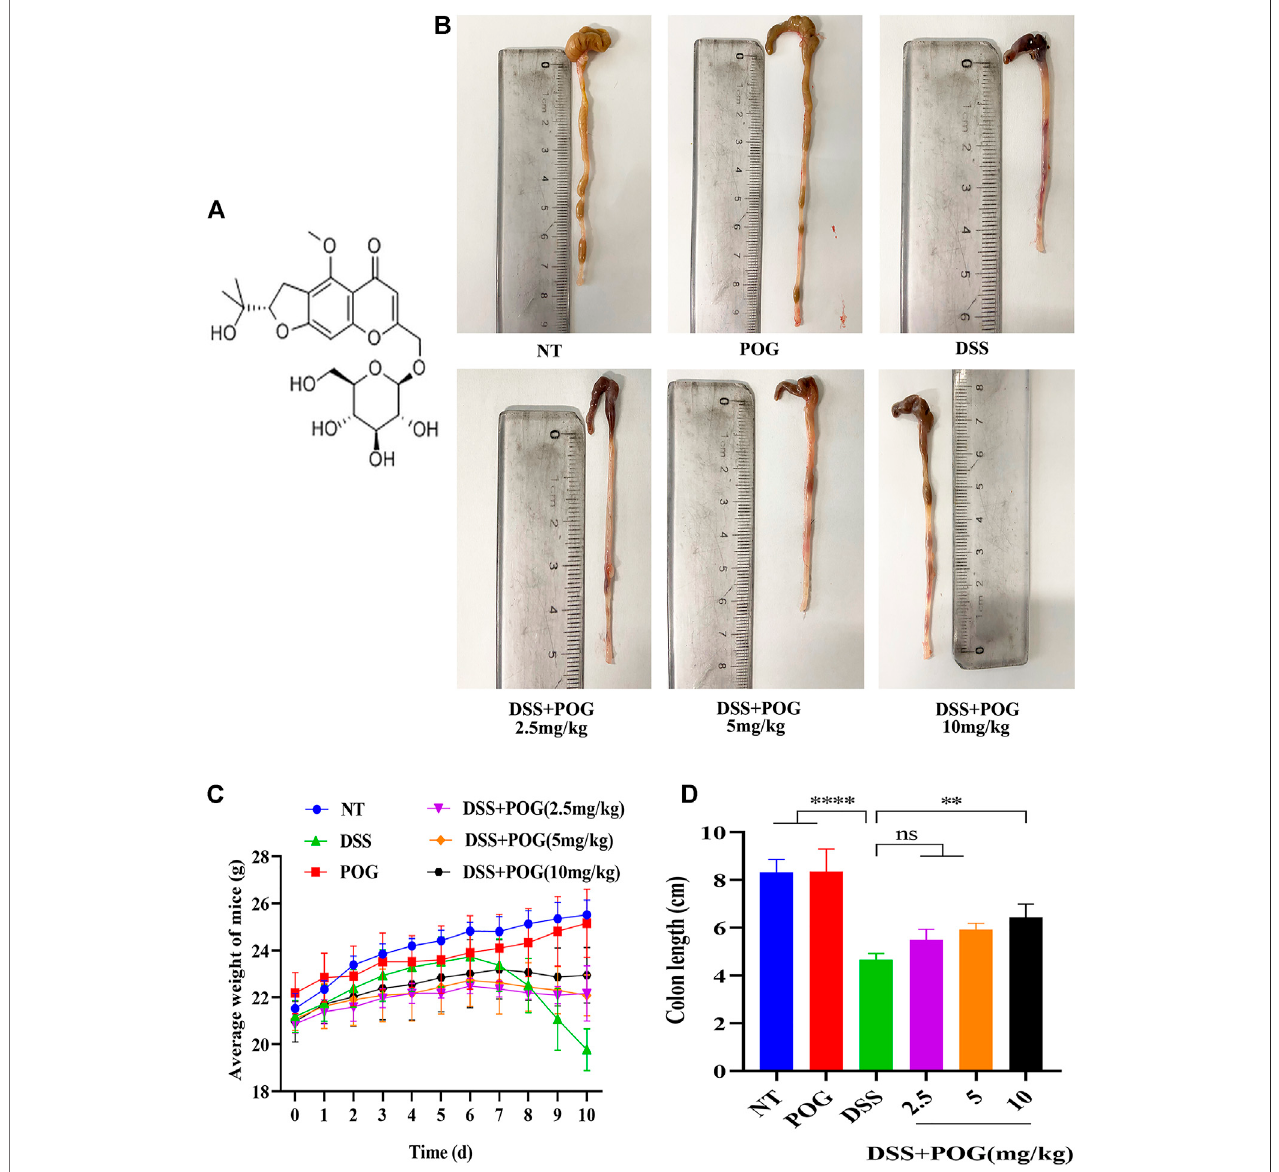
FIGURE 1 | Protective effect of POG on DSS on colonic injury in mice. (A) POG structural schematic. (B) A representative diagram of the length of the colon samples collected from each group. (C) Changes in the daily average body weight of each experimental group ( n = 6). (D) Average length of the colon in each group.